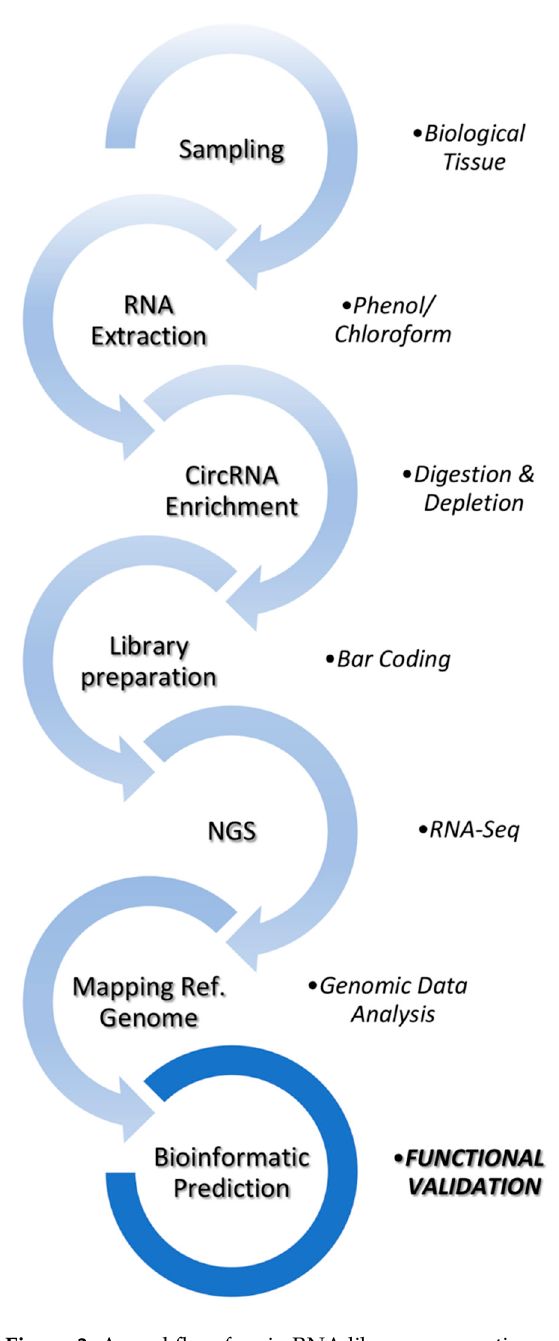
Figure 3. A workflow for circRNA library preparation and computational identification of circRNAs. Experimentally, this can be achieved from linear RNA and rRNA-depleted total RNA using high-throughput sequencing. Afterwards, circRNA can be identified with bioinformatic tools.